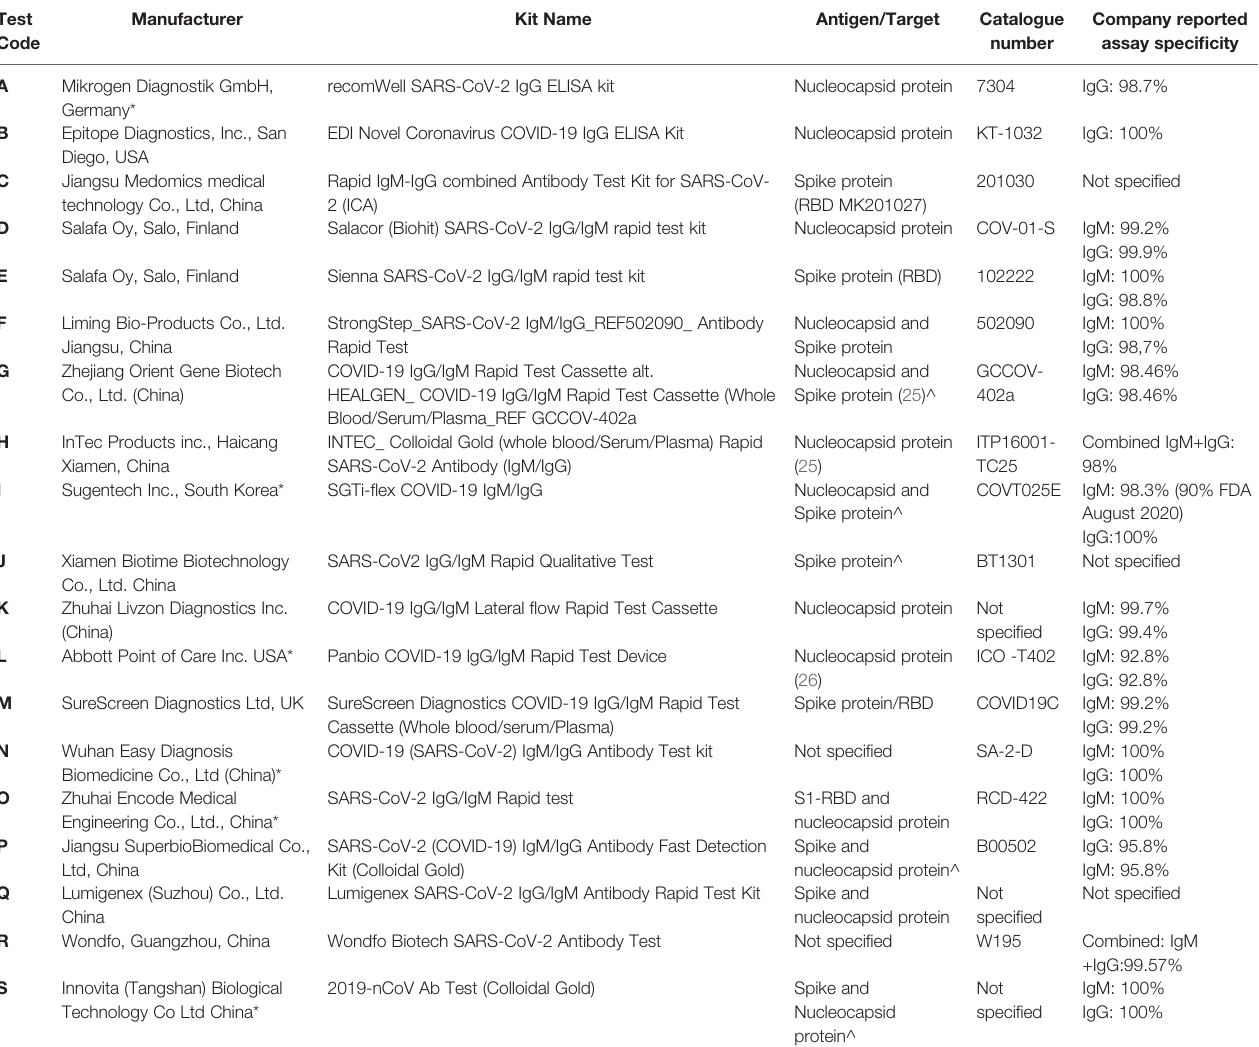
TABLE 2 | Description of the SARS-CoV-2 serological assays and the test codes used in this study. Test